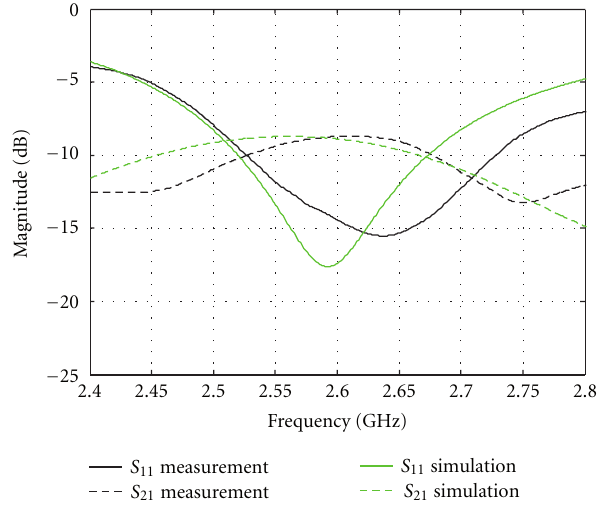
Figure 16: S-parameters of the MIMO antenna system of the MIMO antenna system #3 (measurements versus simulations).